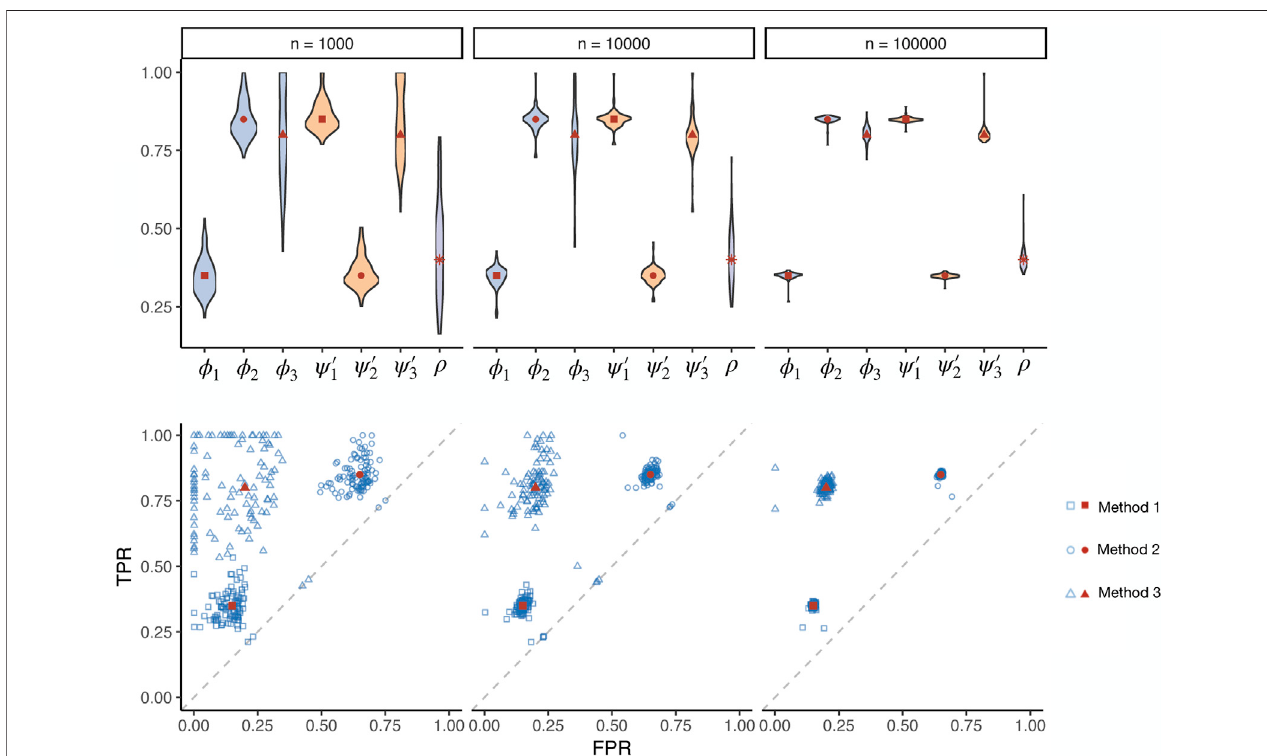
FIGURE 1 | Simulations assessing the maximum likelihood estimation of operating characteristics in the absence of a gold standard. Three methods (represented by squares, circles, and triangles, respectively) with known true sensitivities and speci fi cities (red dots) were simulated, applied on different numbers of tests in total ( n ) with a pre-de fi ned prevalence of true positives. The estimated (blue dots) prevalence ( ρ ), sensitivity ( ϕ ), and speci fi city ( ψ ′ ) parameters are visualized for 100 simulation repeats. TPR: true positive rate. FPR: false positive rate.